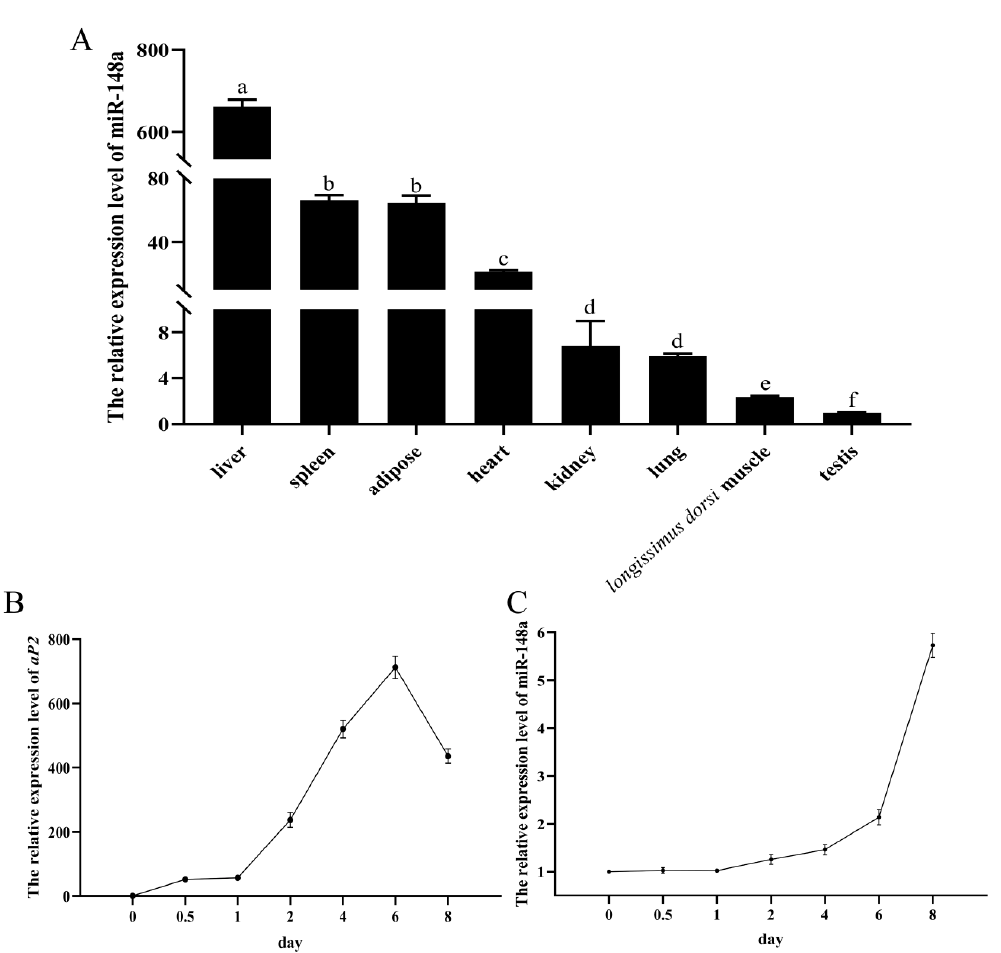
Figure 1. The tissue expression profiles of miR-148a and aP2 . ( A ) The expression level of miR-148a in the eight different tissues of Tibetan ewes. The expression levels of aP2 ( B ) and miR-148a ( C ) during differentiation of ovine preadipocytes using RT-qPCR. The results are depicted as the mean ± SD ( n = 3). Means with a lower-case letter are significantly different ( p < 0.05).